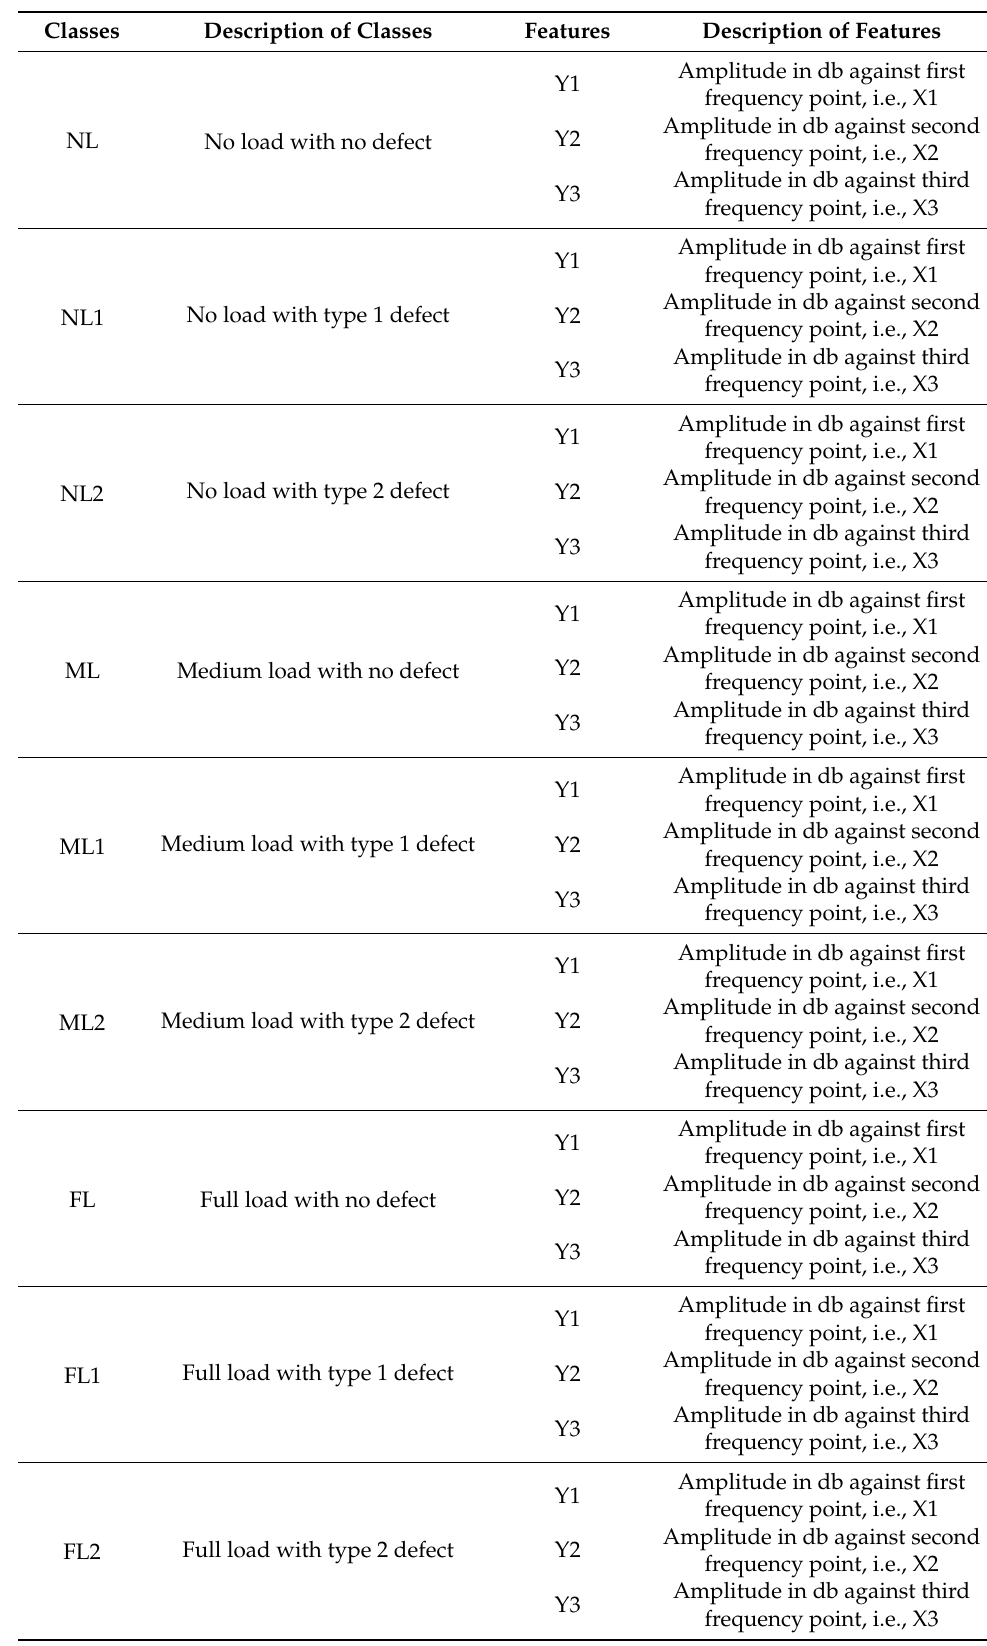
Table 3. Description of classes and